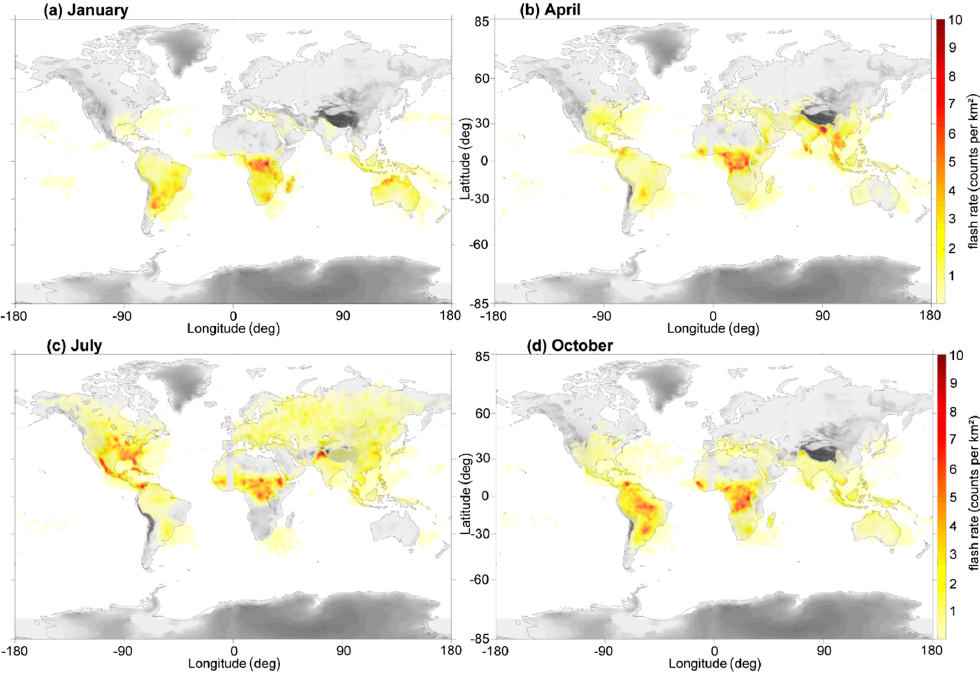
Figure A2. Lightning maps showing the monthly-mean flash rate in ( a ) January, ( b ) April, ( c ) July, and ( d ) October [27].